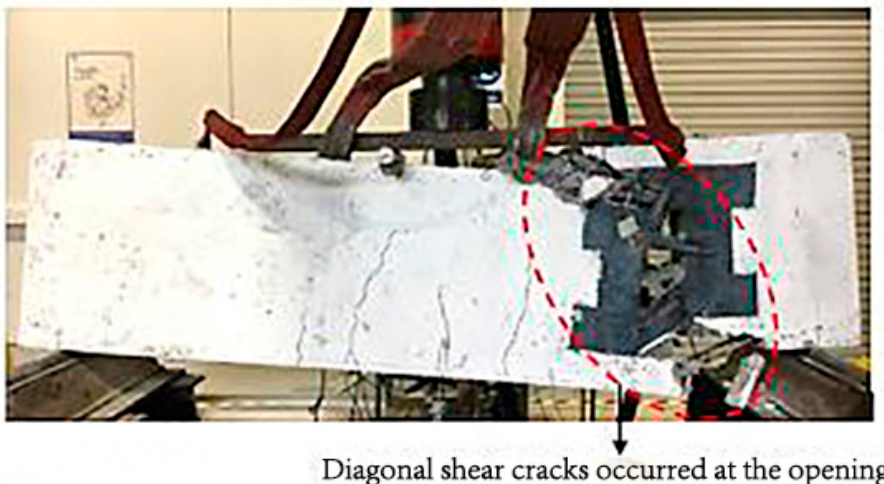
Figure 7. Failure mode and cracking pattern of the deep beam, B1a, at failure.